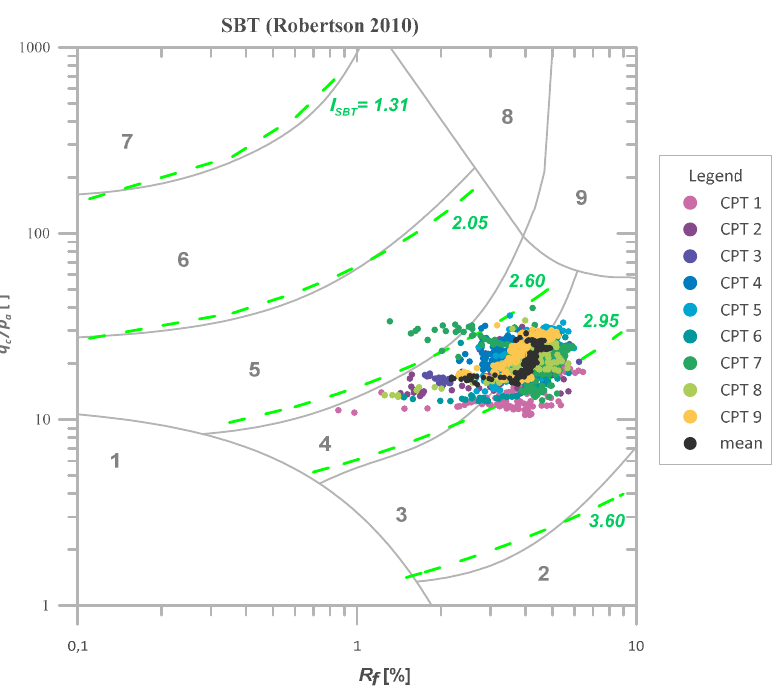
Figure 3. Results of nine CPTs from Ś wierzna [42]; ( a ) cone resistance q c and sleeve friction f s vs. depth; ( b ) nonnormalized SBT index ( I SBT ) vs. depth.